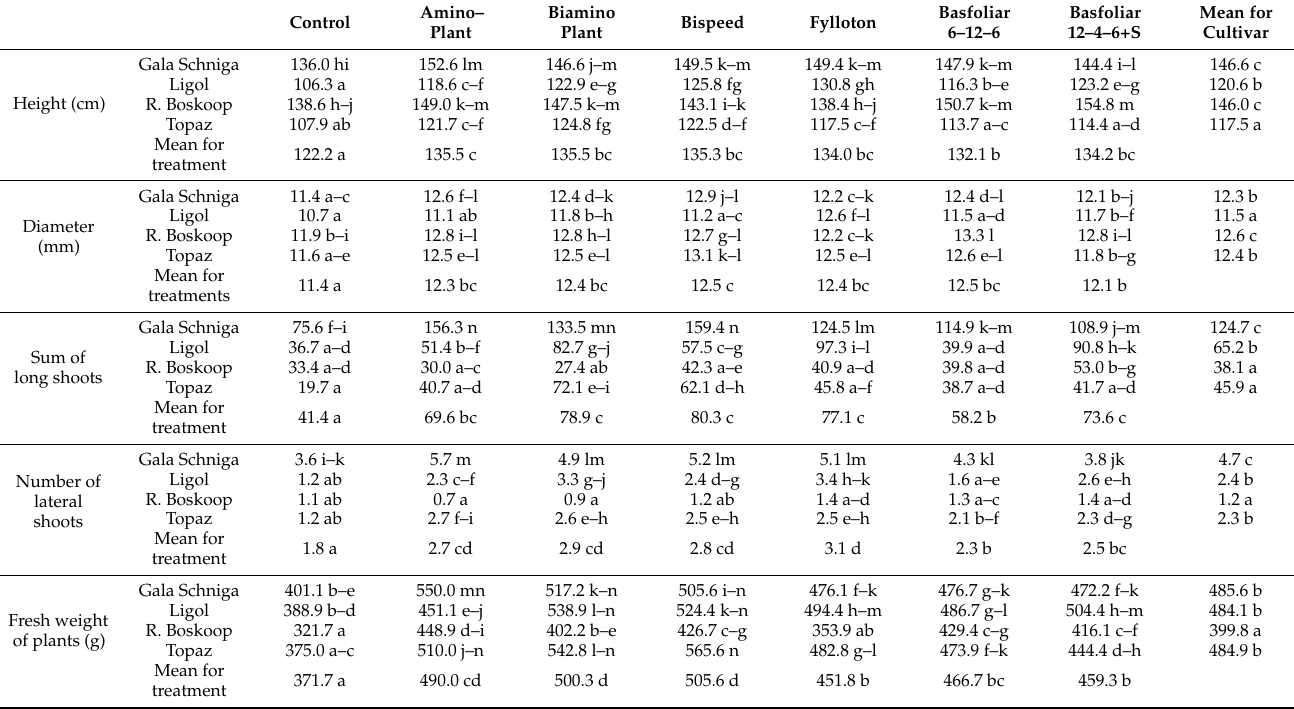
Table 2. Growth parameters of four cultivars of maiden apple trees subjected to four biostimulants and two fertiliser treatments (mean from years 2016–2018).